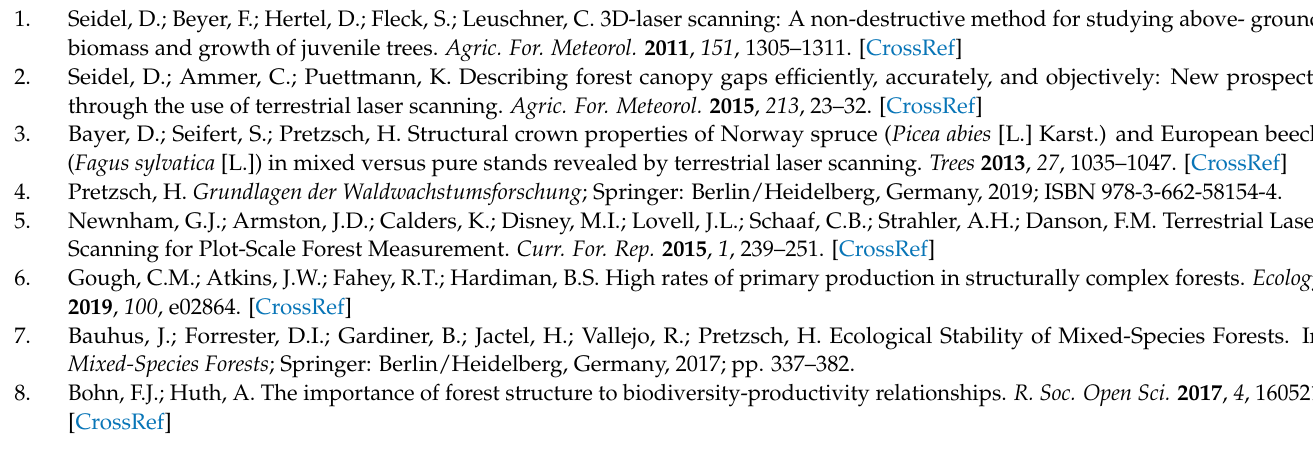
Figure S2: Methodological comparison of different point cloud sections for the beech and spruce stands between the ground scans and the full scans conducted in winter depending on different spatial resolutions. The boxplots are based on six circular subplots, each with a radius of 5 m. Shown are the box dimensions for point cloud sections of 1–12 m, 13–24 m and 25–36 m and the total point cloud. Asterisks indicate significant differences between the scans (*: p ≤ 0.05; ns: p >